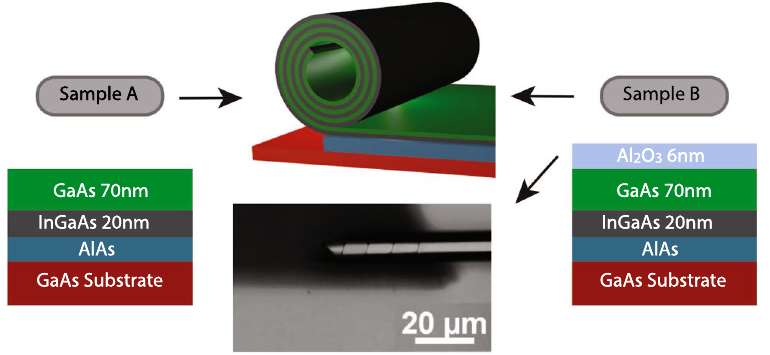
Figure 1. Sample structure with GaAs substrate and AlAs sacrificial layer and on top the rolled-up SL (middle part). Before the roll-up, sample A p (left part) consists of a layer of GaAs and In 0.2 Ga 0.8 As while sample B p (right part) has an additional layer of amorphous Al 2 O 3 on top of the GaAs and In 0.2 Ga 0.8 As layers. The bottom part in the middle shows an image of sample B r taken with an optical microscope. The number of windings increases from the left to the right from 1 to 5 which is controlled by the roll-up